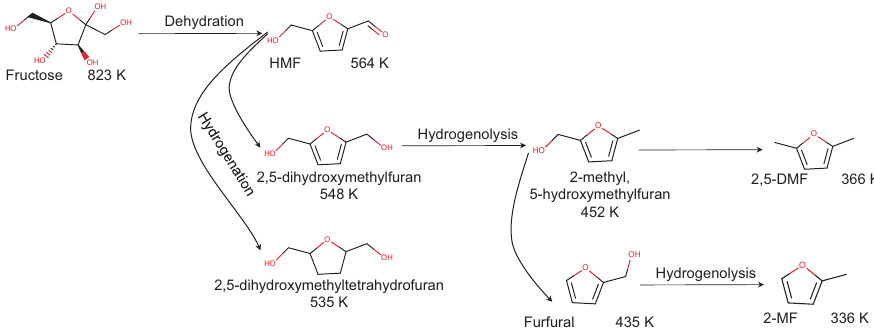
Figure 3. A schematic for the production of 2,5-DMF, 2-MF and other biofuels from fructose (adapted from Román-Leshkov et al.